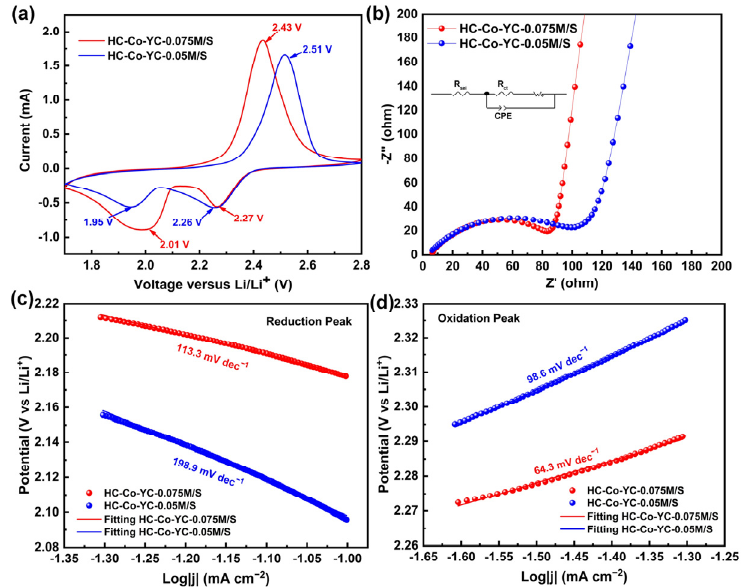
Figure 7. Electrochemical performance of HC–Co–YC–0.05M/S and HC–Co–YC–0.075M/S electrodes: ( a ) CV curves (0.1 mV s − 1 ), ( b ) Nyquist plots and equivalent circuit diagram, and Tafel plots of the ( c ) reduction peak and ( d ) oxidation peak. Table 1. Comparison of the resistance values of the electrode of previous reports with this work.